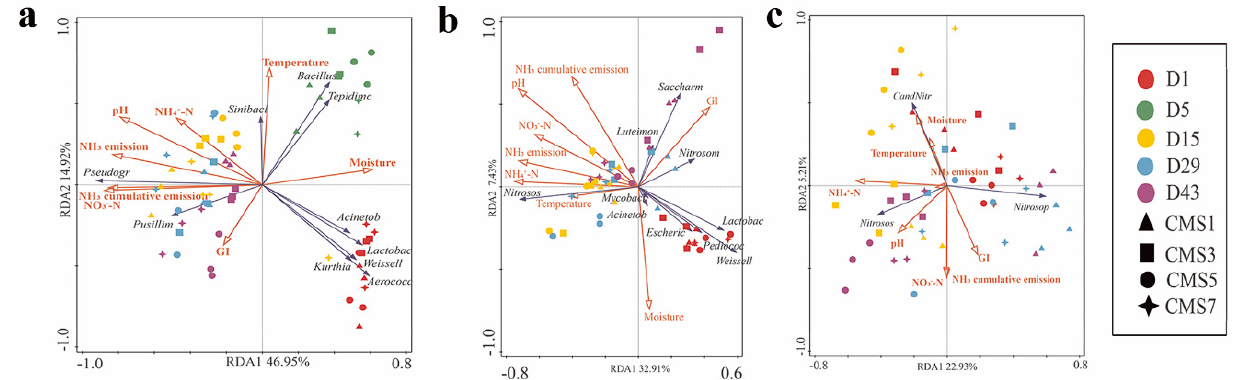
Figure 5. Ordination plots of redundancy analysis for the relationships between environmental factors and bacterial communities at the genus level ( a ), at and between environmental factors and AOB community at the genus level ( b ) and the AOA community at the genus level ( c ) in different treatments during the composting. Pseudogr refers to Pseudogracilibacillus , Aerococc refers to Aerococcus , Lactobac refers to Lactobacillus , Tepidimi refers to Tepidimicrobium , Weissell refers to Weissella , Pusillim refers to Pusillimonas , Sinibaci refers to Sinibacillus , Acinetob refers to Acinetobacter , Nitrosos refers to Nitrosospira , Nitrosom refers to Nitrosomonas , Saccharo refers to Saccharomonospora , Pediococ refers to Pediococcus , Escheric refers to Escherichia , Mycobact refers to Mycobacterium , Luteimon refers to Luteimonas , Nitrosop refers to Nitrosopumilales , Nitrosos refers to Nitrososphaerales .